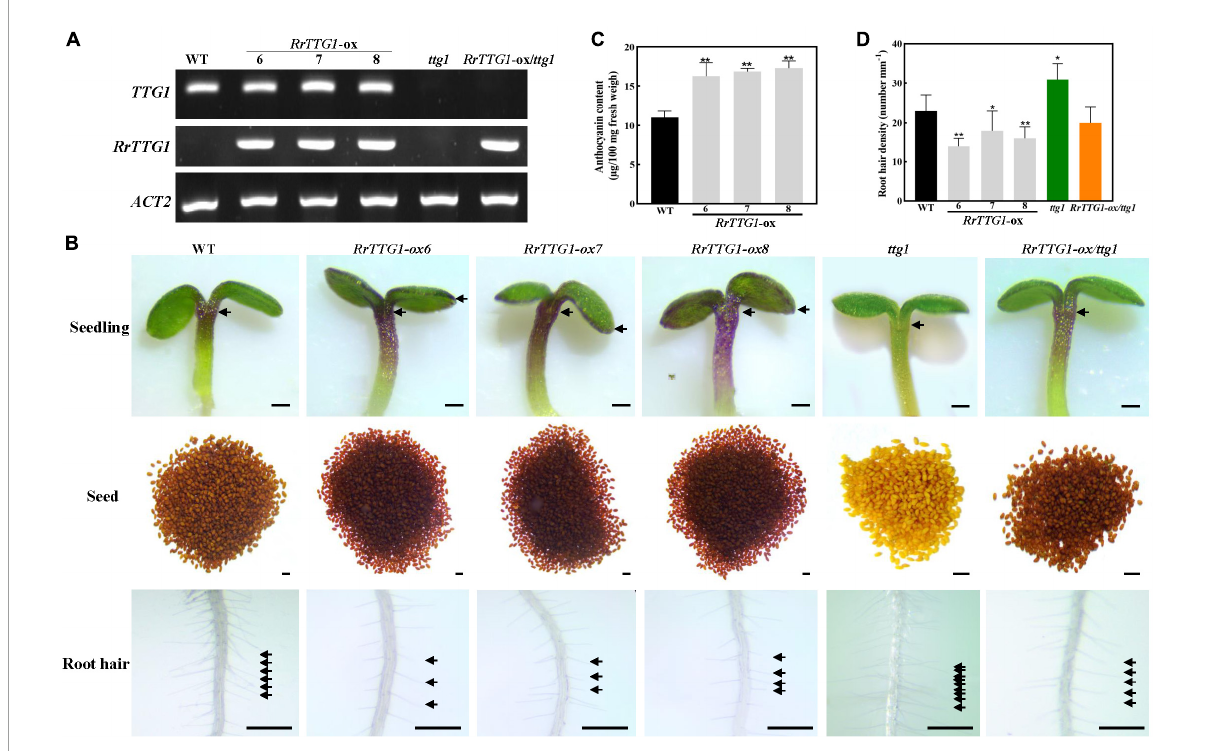
FIGURE4 RrTTG1 promoted anthocyanin content and inhibited root hair formation. (A) Expression of TTG1 and RrTTG1 in WT (Col-0), ttg1 mutant, and transgenic plants ( RrTTG1 -ox and RrTTG1 -ox/ ttg1 ). RT-PCR was used to detect the expression of TTG1 and RrTTG1 , and ACT2 was used as a control. Primers are listed in Supplementary Table 1 . (B) Ectopic expression of RrTTG1 could promote anthocyanin content and inhibit root hair formation in Arabidopsis . The seeds and 5-day-old seedlings were collected for anthocyanidin observation. Root hair located 5 mm above the root tip was observed, bar = 1 mm. (C) Ectopic expression of RrTTG1 could promote anthocyanin content. The anthocyanin contents of 4-week-old WT and RrTTG1-ox transgenic plants were measured by HPLC analysis. (D) Ectopic expression of RrTTG1 could reduce the root hair density. The number of root hairs per mm (root hair density) of WT, ttg1 mutant, and transgenic plants ( RrTTG1 -ox and RrTTG1 -ox/ ttg1 ) was counted ( n = 30). Data are mean ± SD and analyzed using one-way ANOVA (** p < 0.01, * p <